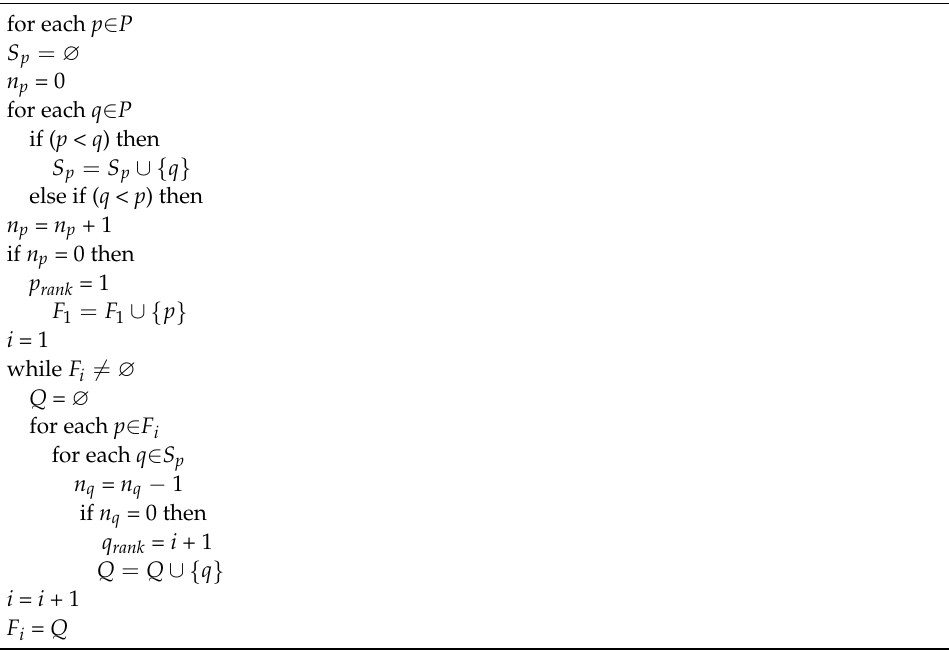
Algorithm 1. Fast-Nondominated-Sort(P) [28]